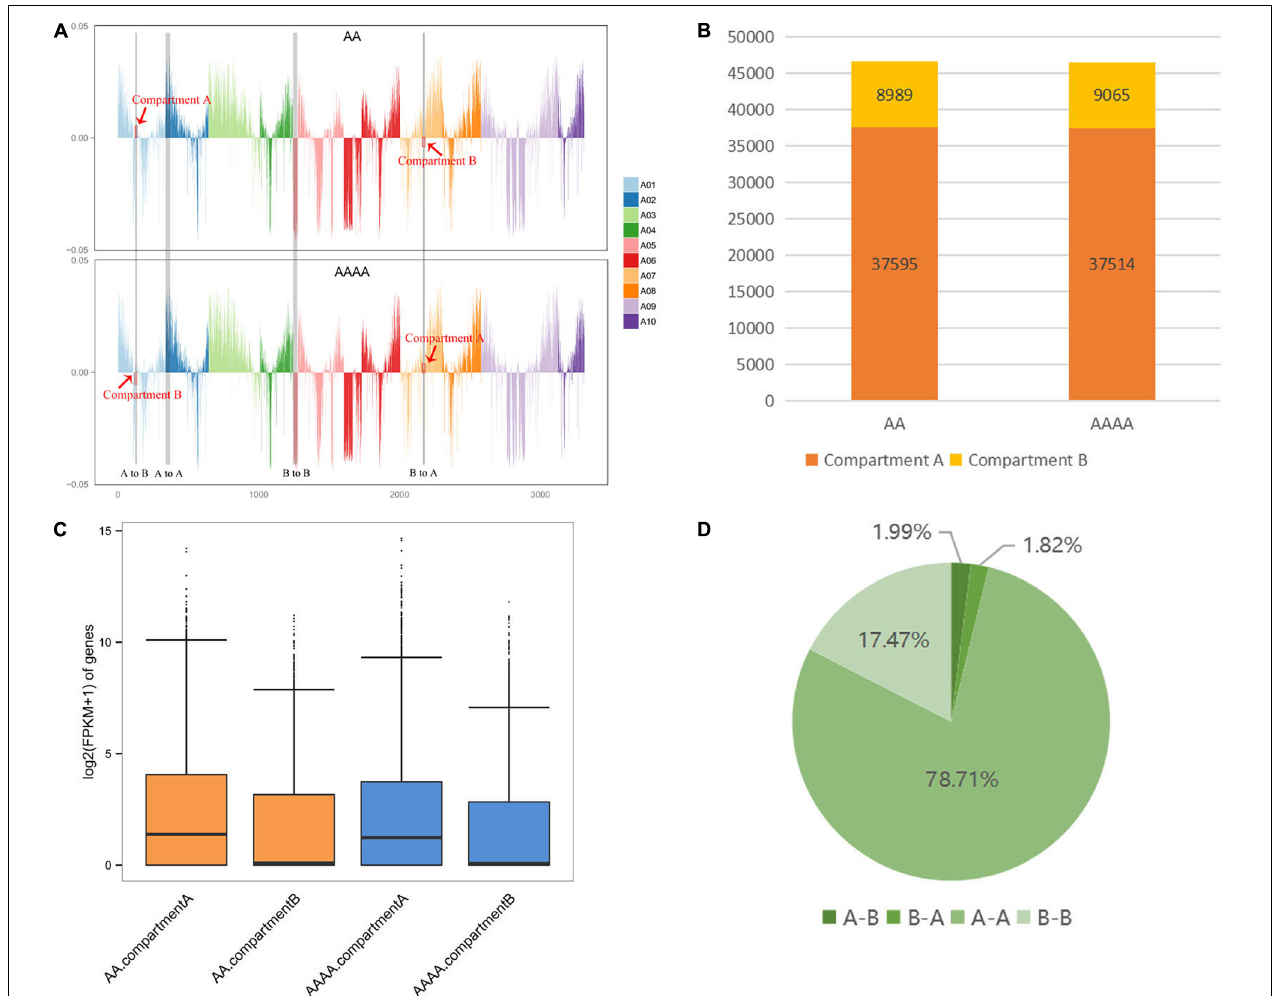
FIGURE 3 | The analysis of the A/B compartments in diploid and autotetraploid pak choi. (A) The distributions of the A/B compartment on each chromosome. With the y -axis 0 scale line as the reference, above is Compartment A and below is Compartment B. (B) The number of genes contained in the A and B compartments. (C) Box plots representing the gene expression on the A and B compartments. (D) The percentage of the A/B compartment shifts between diploid and autotetraploid pak choi.